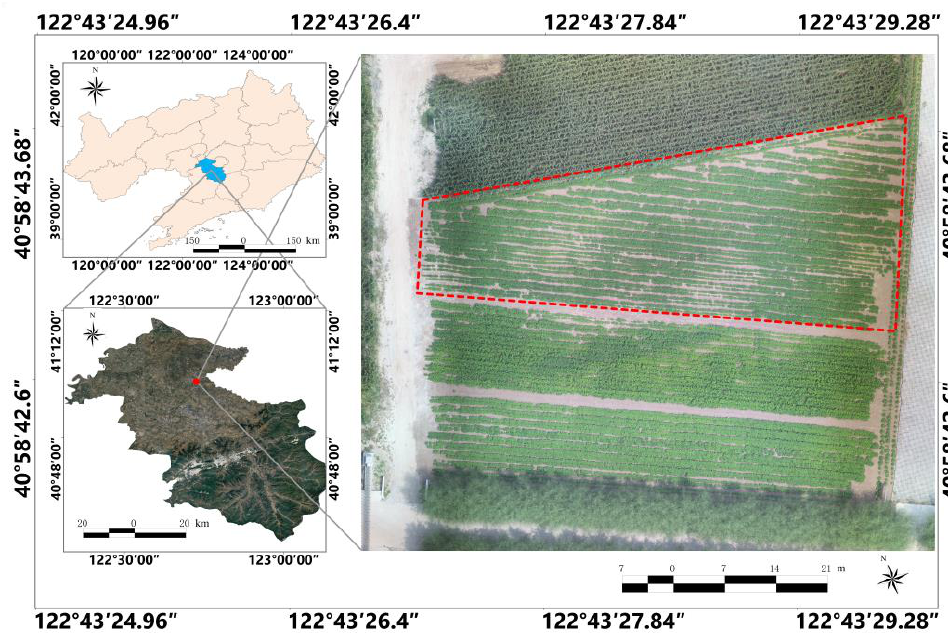
Figure 1. Location and overview of the experimental site. Table 1. Disease severity levels at leaf scale.